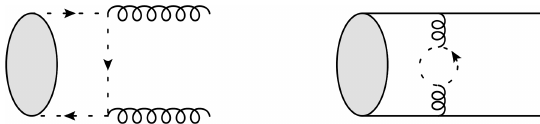
Figure 1 . Examples of possible ghost contributions to the virtual corrections; due to the nature of the ghost coupling the diagram on the left hand side does not contribute in the soft limit. On the right hand side the ghost contribution for the gluon self energy is depicted, which needs to be included since it has the same momentum scaling as the three gluon vertex when all attached lines become